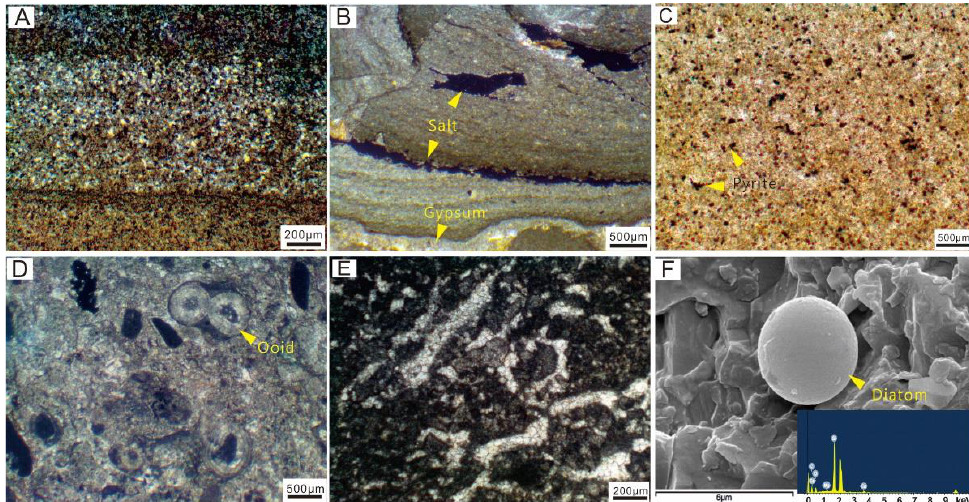
Figure 3. D1 dolomite: ( A ) very fine-crystalline dolomite with horizontal bedding, well BT5, 4742.29 m, Є 3 x, under plane-polarized light (PPL). ( B ) Micritic dolomite laminae interbedded with salt and anhydrite laminae (arrows), well HT5, 6162 m, Є 2 a, under PPL. ( C ) Cryptocrystalline pyrites (arrows) disseminated within intercrystalline pores, well HT1, 6433 m, Є 2 a, under PPL. ( D ) Precursor limestone ooid (arrows) replaced by dolomicrite, well BT5, 4742 m, Є 3 x, under PPL. ( E ) Microcrystalline dolomite with a stromatolitic structure, well XH1, 5436 m, Є 1 w, under PPL. ( F ) Diatom chondrite (arrows) in microcrystalline dolomite, well XH1, 5442 m, Є 1 x, under scanning electron microscope-second electron (SEM-SE).